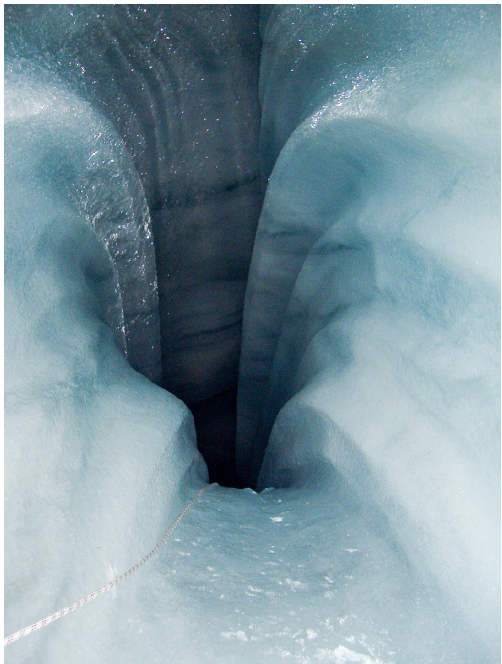
Figure 5. Grooved channel wall morphology over a knickpoint lip in 2005. Flow direction is away from the photographer. See climb- ing rope for scale.